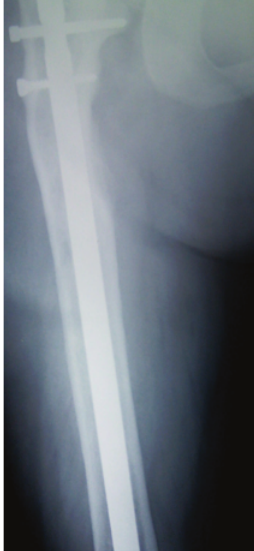
Figure 2: Reconstruction intramedullary nail right femur.